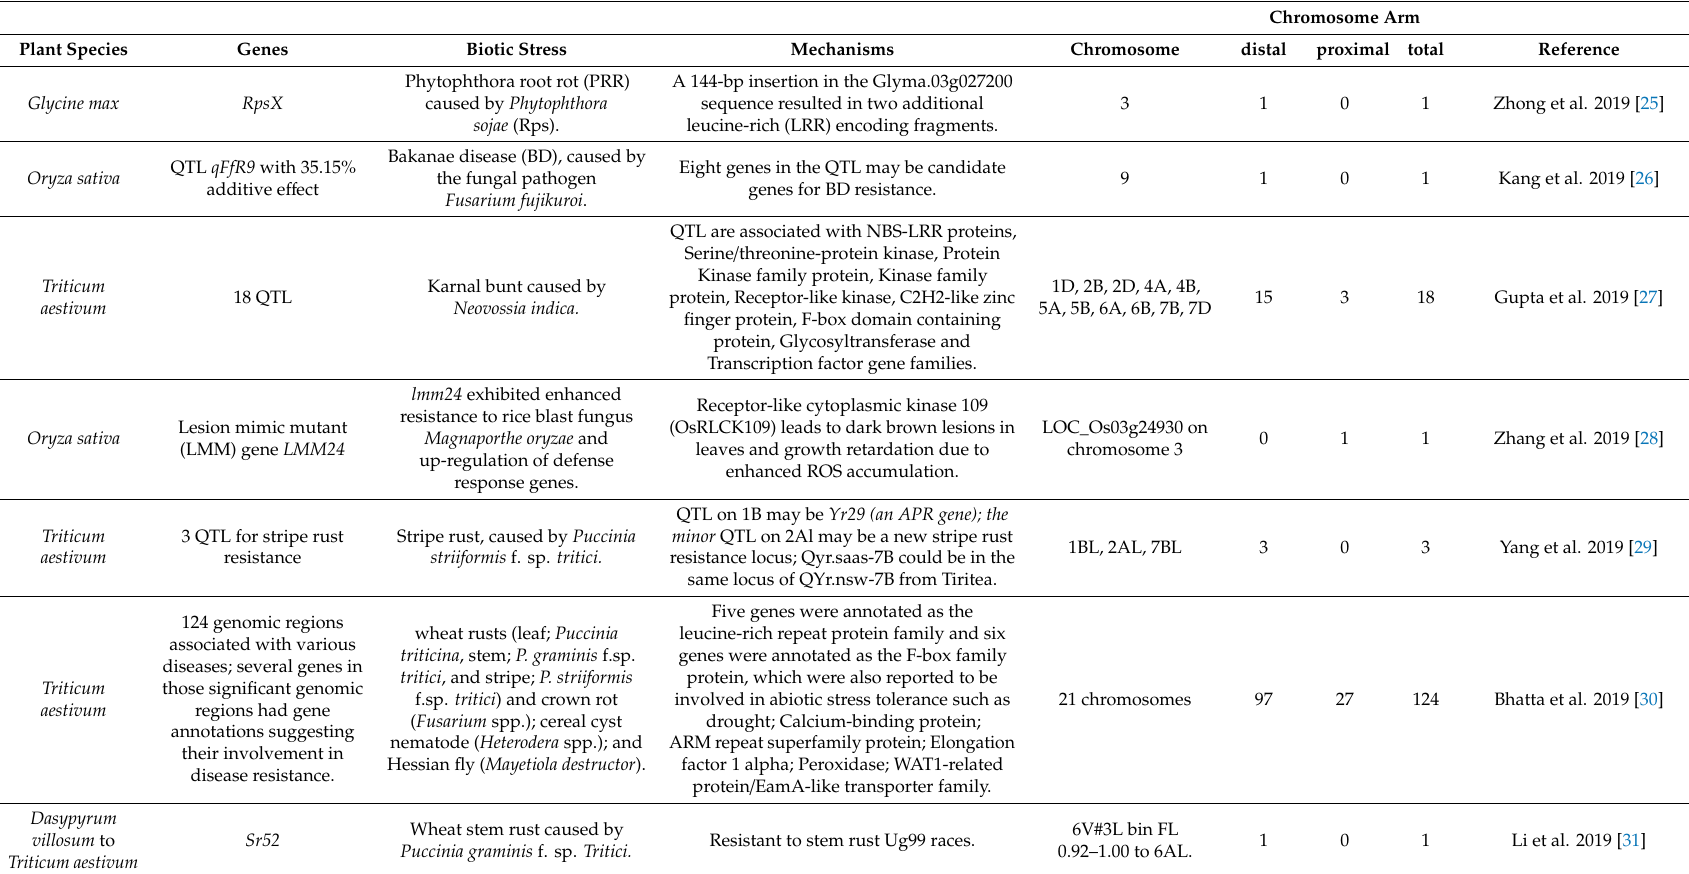
Table 2. Chromosomal distribution of genes controlling resistance to biotic stresses.